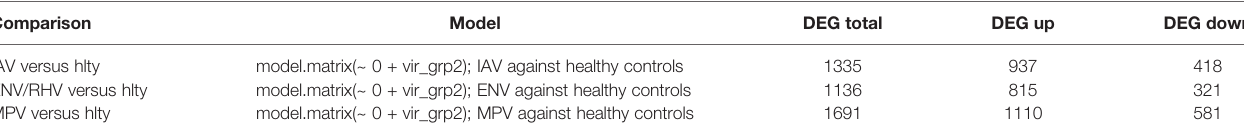
TABLE 2 | List of DEGs for comparison of single respiratory virus infections versus controls. Comparison